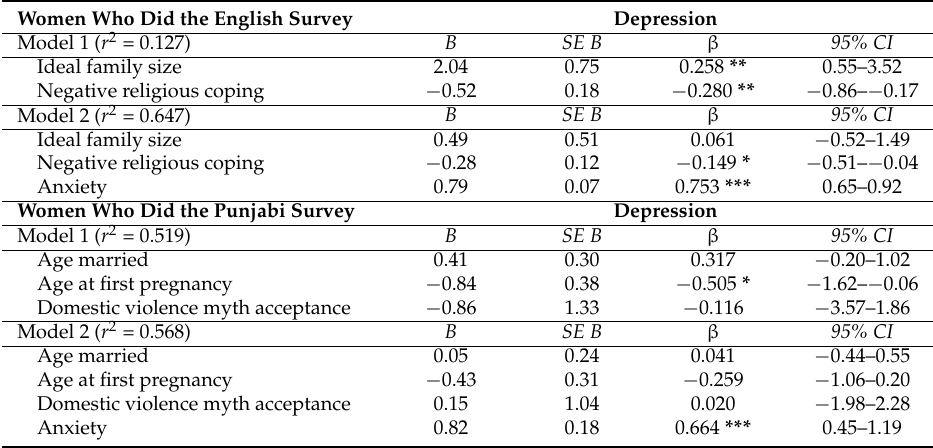
Table 4. Predictors of depression among AI immigrant